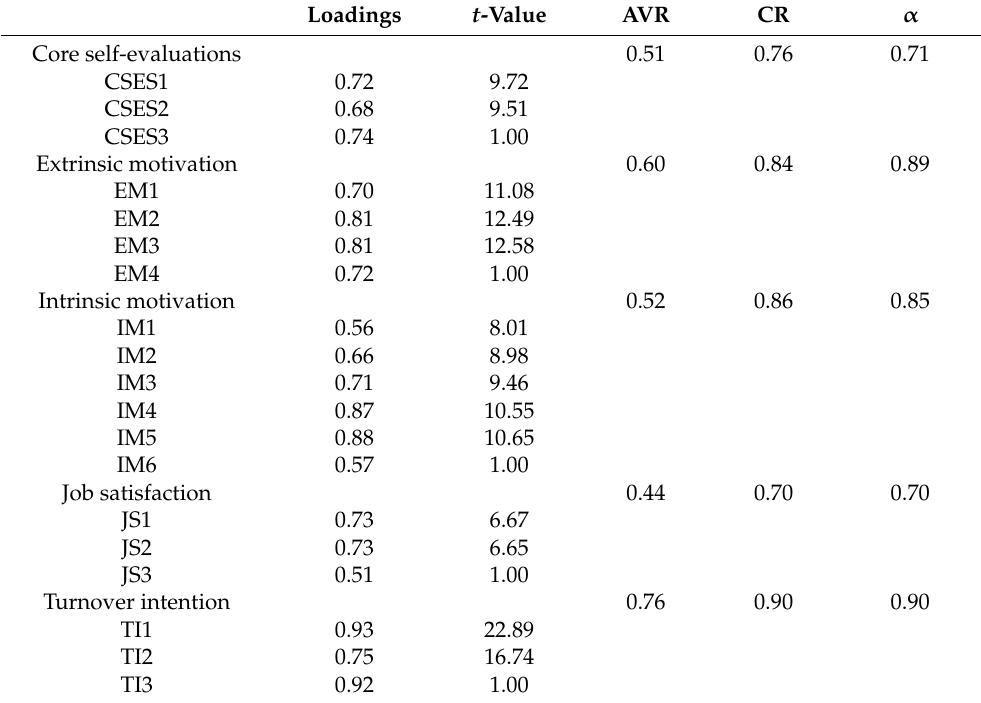
Table 2. Factor loadings and CFA